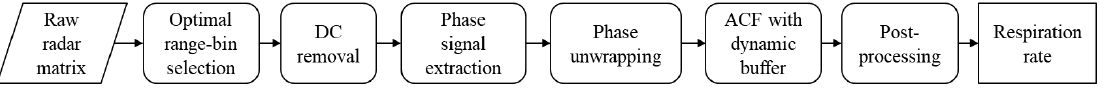
Figure 5. Respiration signal